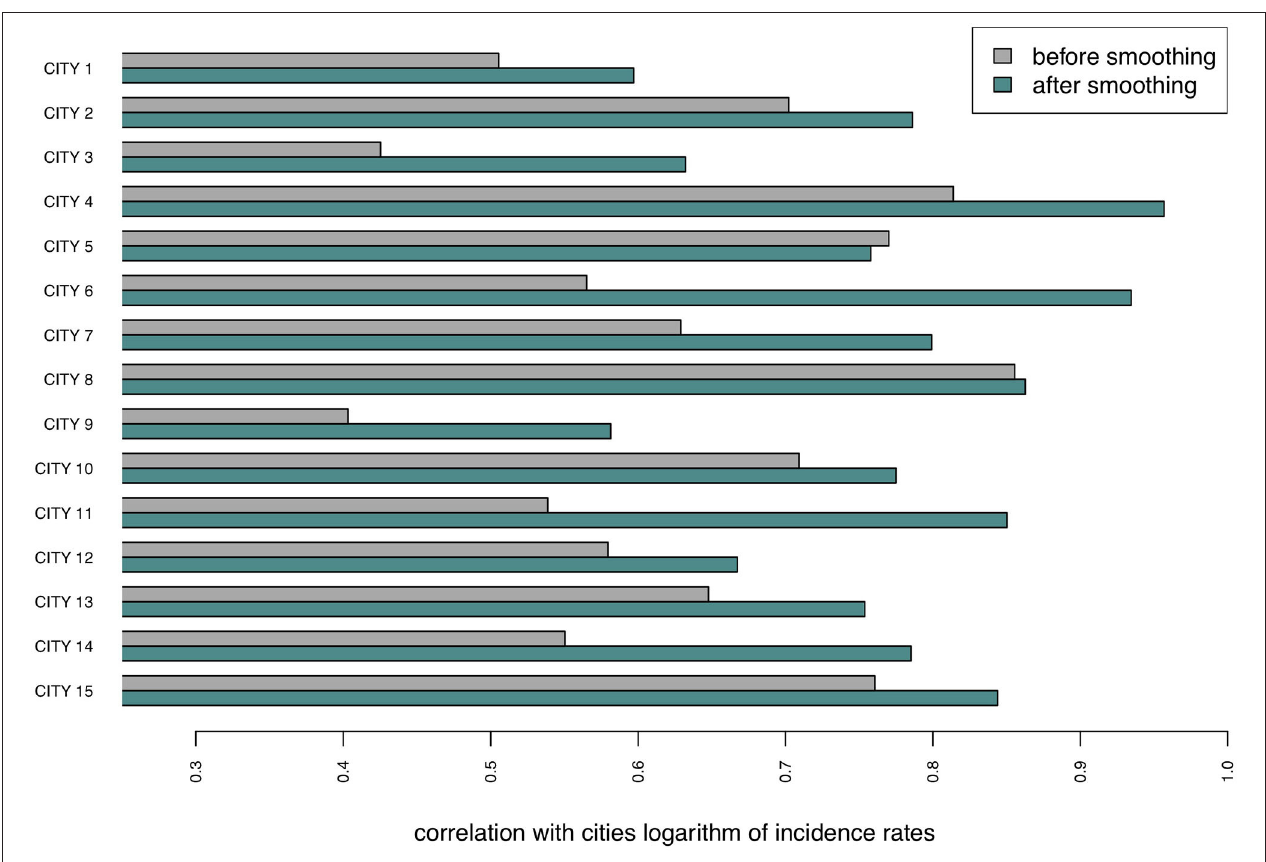
FIGURE 9 | Correlation of raw Obépine data and flow-adjusted and smoothed Obépine data with the logarithm of incidence rates of the corresponding cities for 15 cities with enough data available on both sides, for a lag time ranging from 1 to 3 days in both directions and for a period ranging from the beginning of the second wave to the May 21,